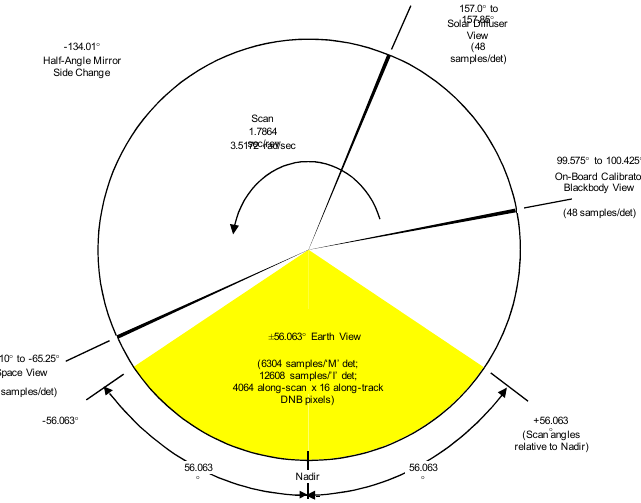
Figure 2. VIIRS scan section diagram illustrating the different collection regions and their angles during a single scan.